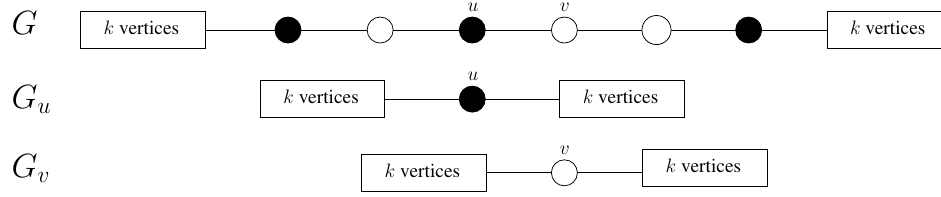
Figure 12 . A local algorithm A with locality distance k has to take the same decisions for the vertices u and v in G , G and G . The black vertices show a possible independent set computed by A . In order to 1 u v simplify this figure the rectangular boxes represent k vertices on the